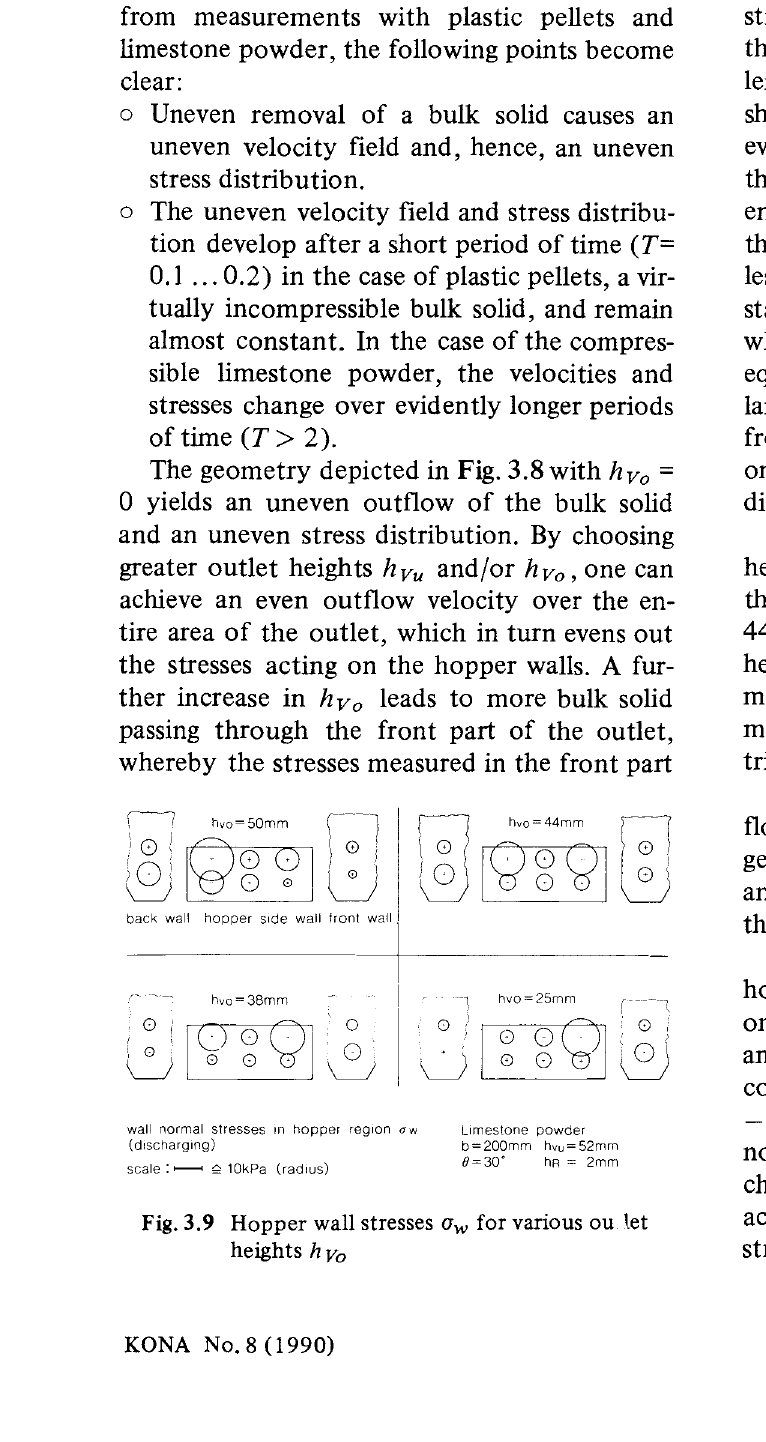
Fig. 3.9 Hopper wall stresses Ow for various ou let heights